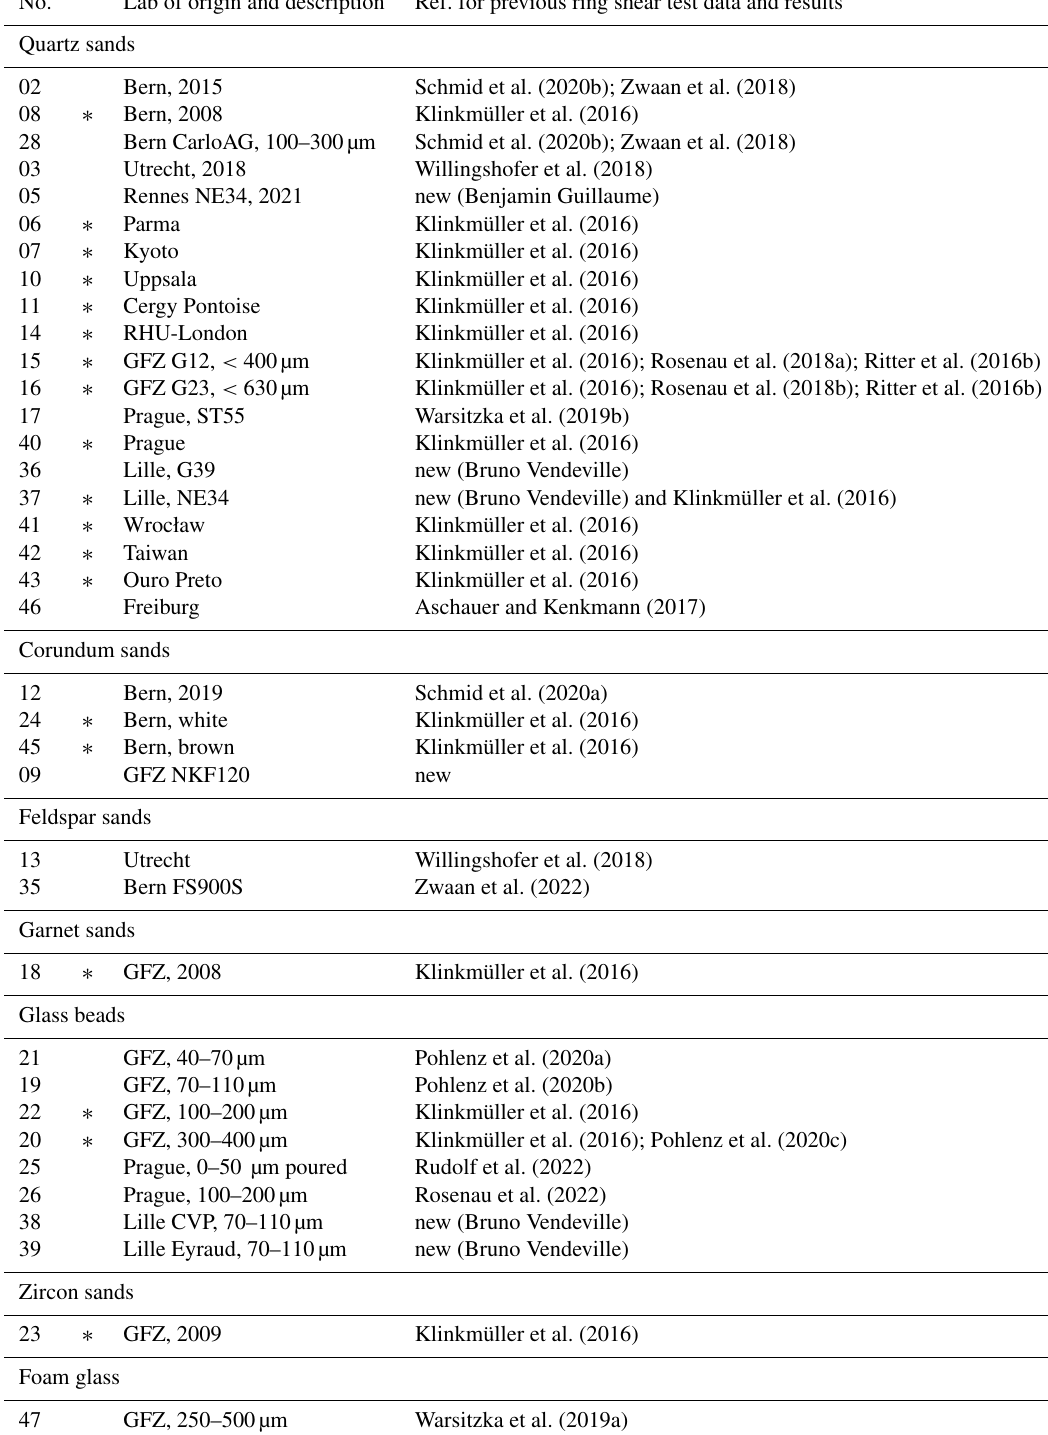
Table 1. Samples included in this study and references showing where standard ring shear tester data can be found. Materials that were included in Klinkmüller et al. (2016) are highlighted with “ ∗ ”. Some materials have not been published previously and are marked with “new”. These have been tested for friction and healing properties. All other samples have only been tested for their healing properties. Sample numbers refer to the numbering scheme of the slide–hold–slide tests found in the data publication.